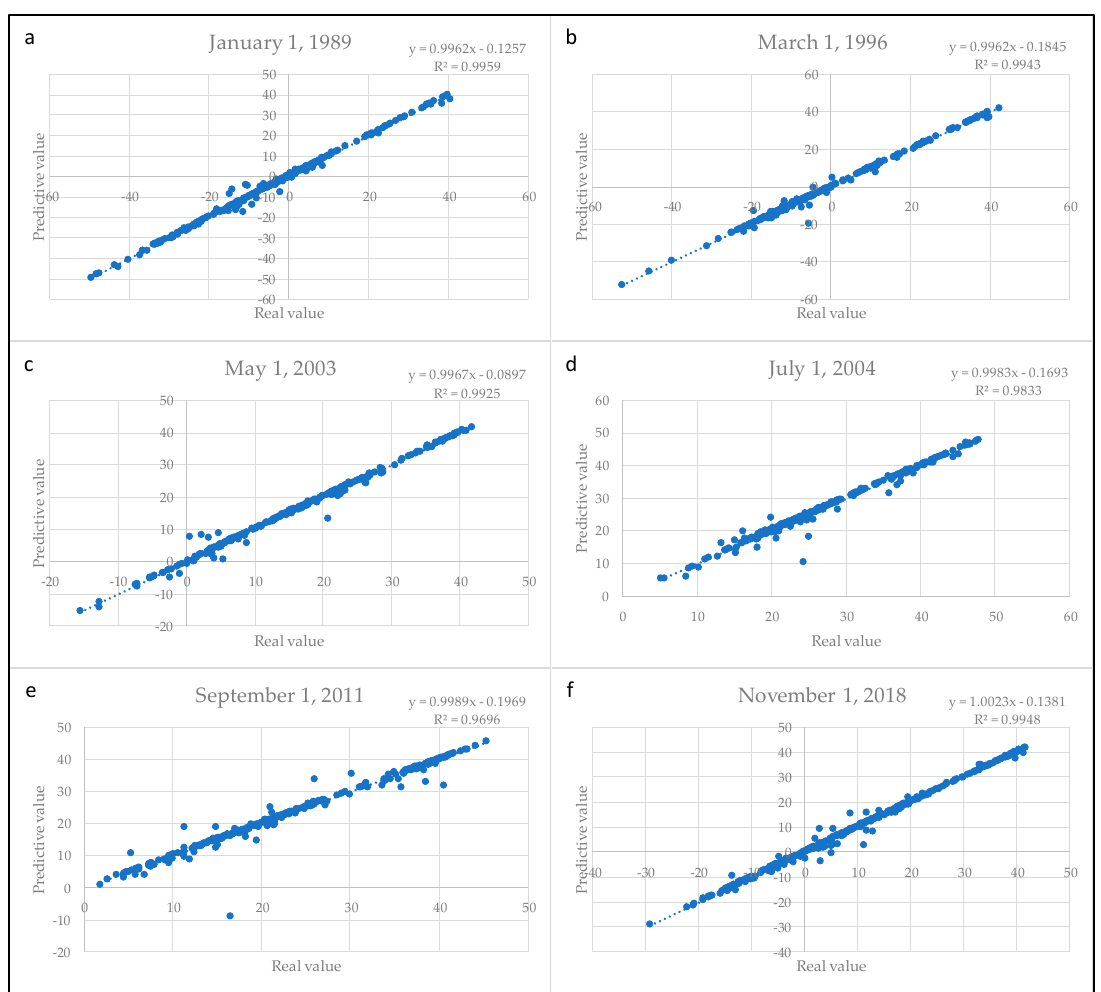
Figure 3. Validation result of apparent temperature for: ( a ) January 1, 1989; ( b ) March 1, 1996; ( c ) May 1, 2003; ( d ) July 1, 2004; ( e ) September 1, 2011; ( f ) November 1, 2018.